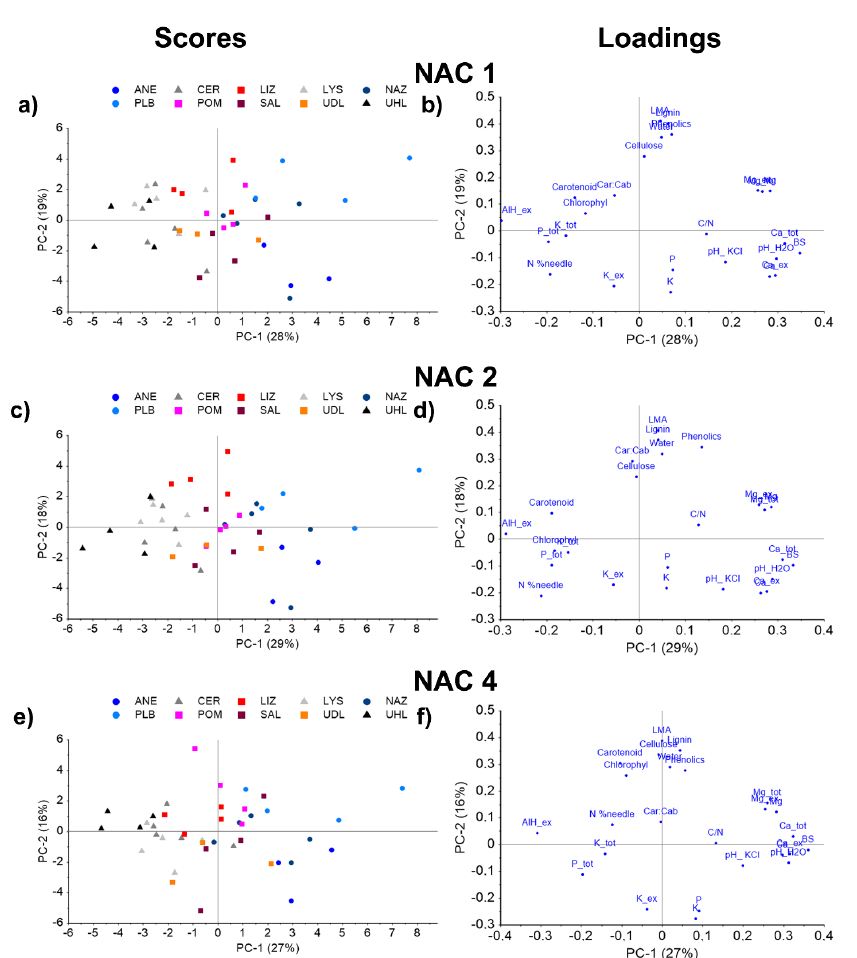
Figure 4. Score plots and loadings plots for PCA applied on needle traits and FH horizon soil properties of GEOMON catchments (for site description see Table 1). For each model, the needle traits from one needle age class were included: ( a , b ) NAC1; ( c , d ) NAC2; ( e , f ) NAC4. Needle traits: Carotenoids—total carotenoids content; Chlorophyll—total chlorophyll content; Lignin—lignin content; Phenolics—content of total soluble phenolics; Water—water content; LMA—leaf mass per area; Car:Cab—total carotenoids to total chlorophyll ratio; N% needle—needle nitrogen content related to dry mass. Soil properties: AlH_ex—total exchangeable acidity; pH_KCl, pH_H2O—pH assessed in KCl and water, respectively; BS—base saturation; Ca_ex, K_ex, Mg_ex—exchangeable base cations (BaCl2); Ca, K, Mg, P available Ca, K, Mg, P (Mehlich); Ca_tot, K_tot, Mg_tot and P_tot—total Ca, K, Mg, P (total digest); C/N—C:N ratio in FH horizon. PC1, driven particularly by exchangeable acidity, total phosphorus content, pH, base 28% ( ± 1%) of total variation for NAC1, NAC2 and NAC4 (Figure 4). The PC2